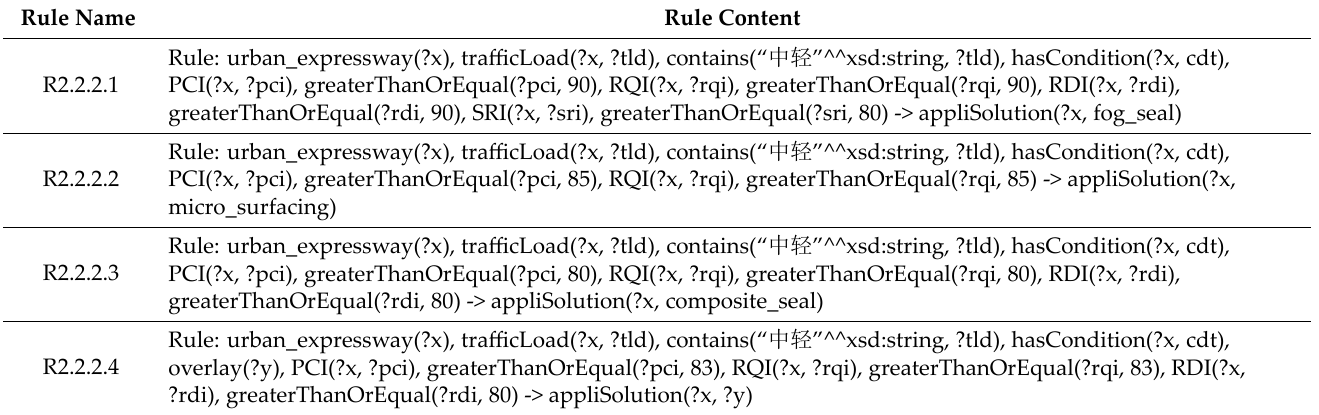
Table A2. Renewal rules for expressways with pavement seepage and moderate/mild traffic load.